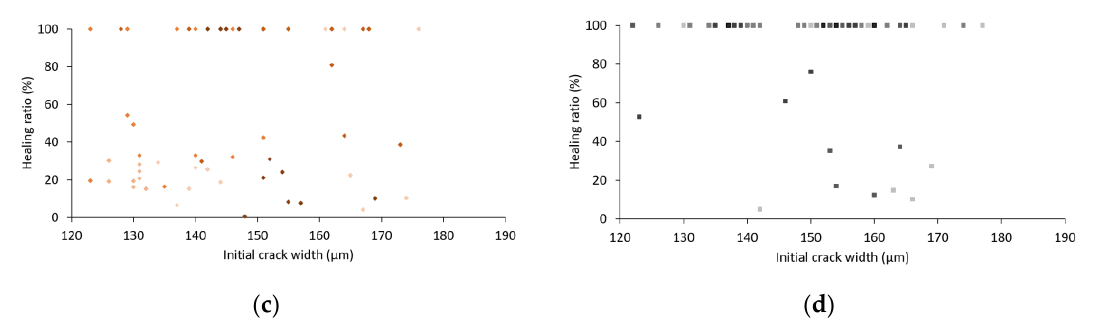
Figure 4. Healing ratio in % versus initial crack width of ( a ) reference, ( b ) 0.2% SAP, ( c ) 2% HS-40 and ( d ) 0.2% SAP + 2% HS-40.